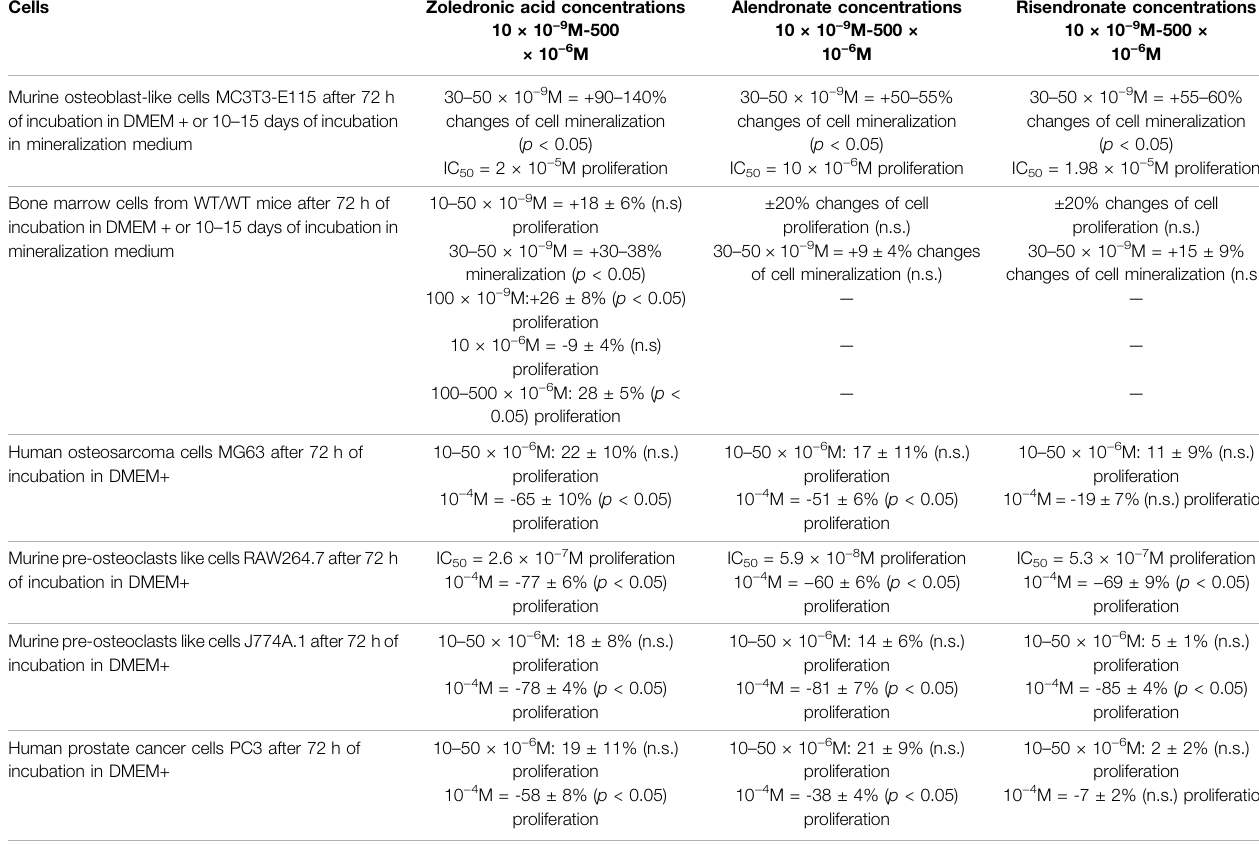
TABLE 1 | Percentage changes of cell proliferation and mineralization with Bis-phosphonates in non-malignant and malignant cells.